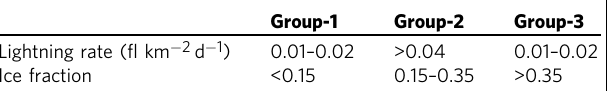
Table 1 Threshold values of lightning rate and ice fraction for the three selected